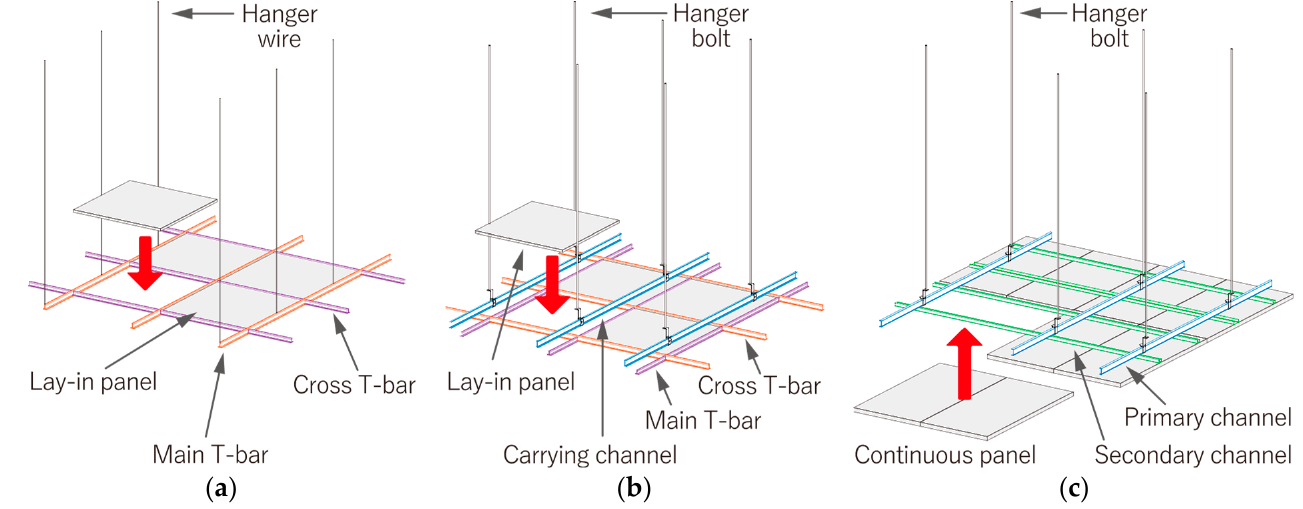
Figure 1. Type of suspended ceiling systems: ( a ) Direct-hung suspended ceiling system; ( b ) indirect- hung suspended ceiling system with lay-in panel; ( c ) indirect-hung suspended ceiling system with continuous panel.